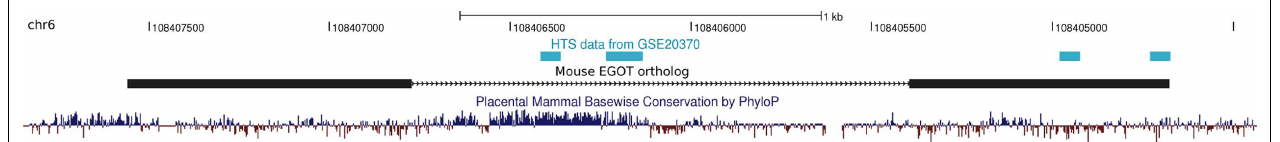
depicted transcribed regions. On the one hand the two independently transcribed regions at the intronic HCE support our findings that the HCE consists of two independent non-coding as well as protein-coding domains. Next, since it was previously postulated that EGOT may act via siRNAs to repress its targets MBP and EDN (Wagner et al., 2007), the signals at the 3 (cid:2) -end on the other hand might indeed indicate small RNAs that are hosted by